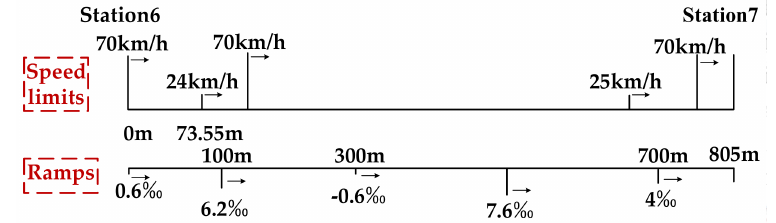
Figure 8. Data of limits and ramps between Station 7 and Station 8.